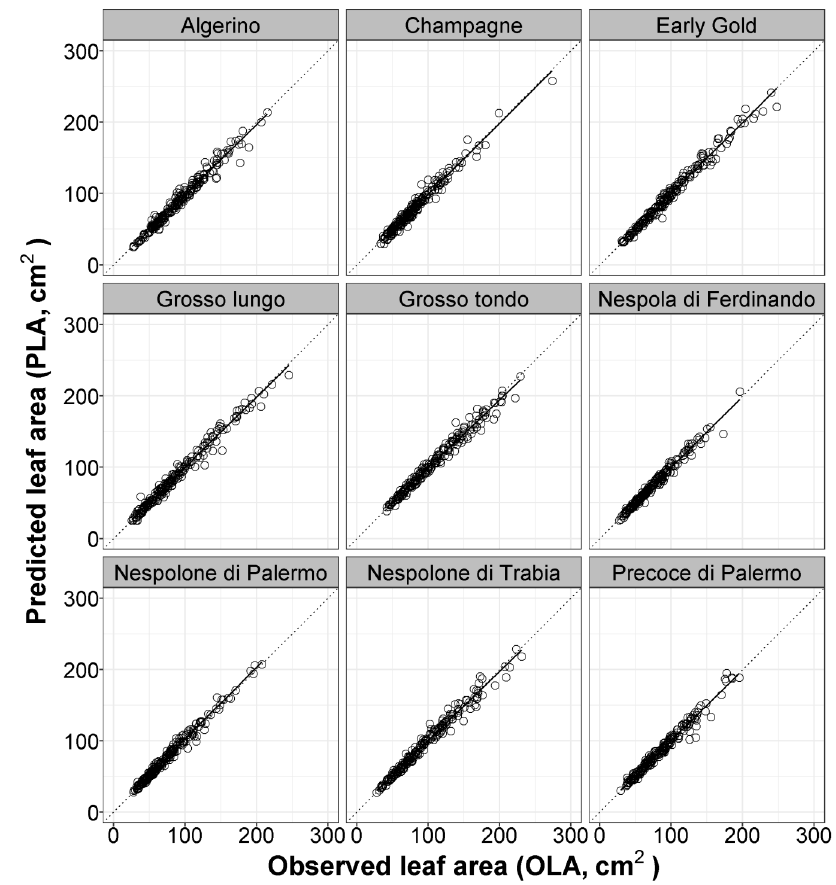
Figure 1. Plots of predicted leaf area (PLA) using model 7 [LA = − 0.516 + 0.667 × (L × W)], obtained with pooled data of nine different loquat cultivars, versus observed values of single leaf areas (OLA) of each cultivar used in the calibration experiment (data collected during 2015). Dotted lines represent the 1:1 relationship between the predicted and observed values. The solid line represents the linear regression line of each model.